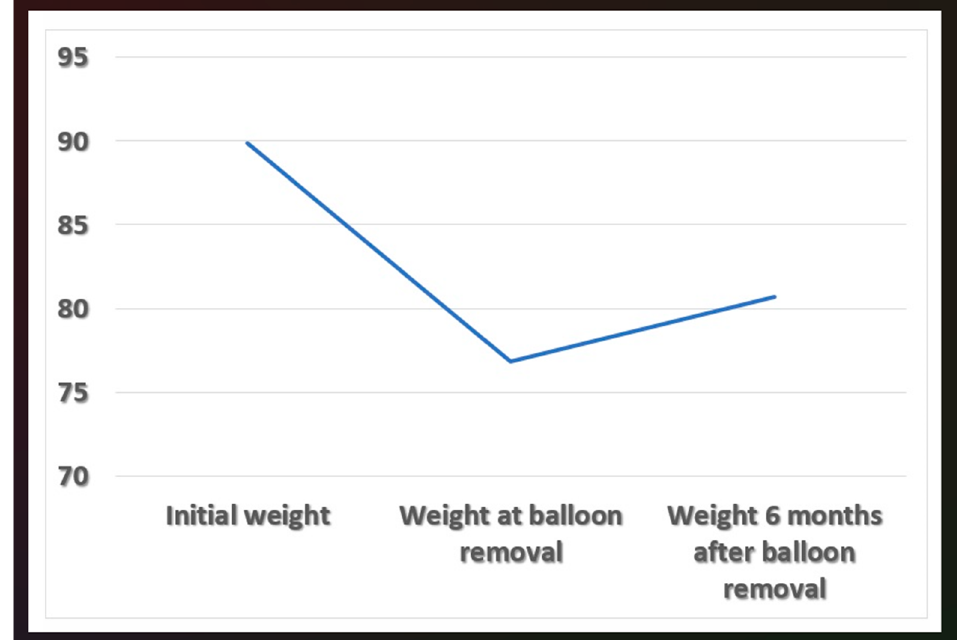
Figure 1. A graph showing the mean initial weight, weight at balloon removal, and 6 months after